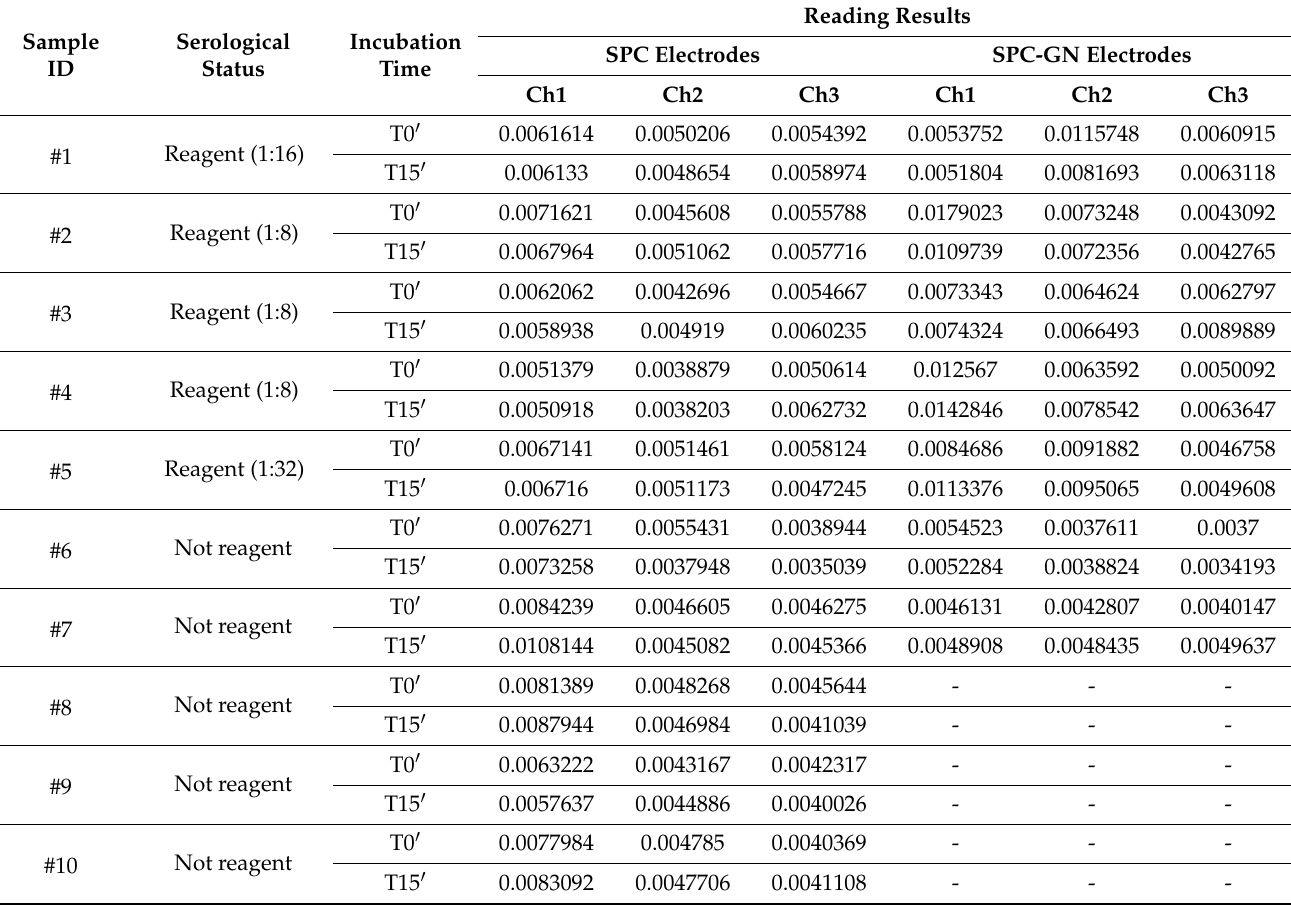
Table 2. Serological status of biological samples and AUC data obtained after incubation with anti- human serum albumin (Ch1), recombinant T. pallidum p47 protein (Ch2), and T. pallidum polyclonal antibody (Ch3) in Poly-L-Lysine-pre-treated SPC and SPC-GN